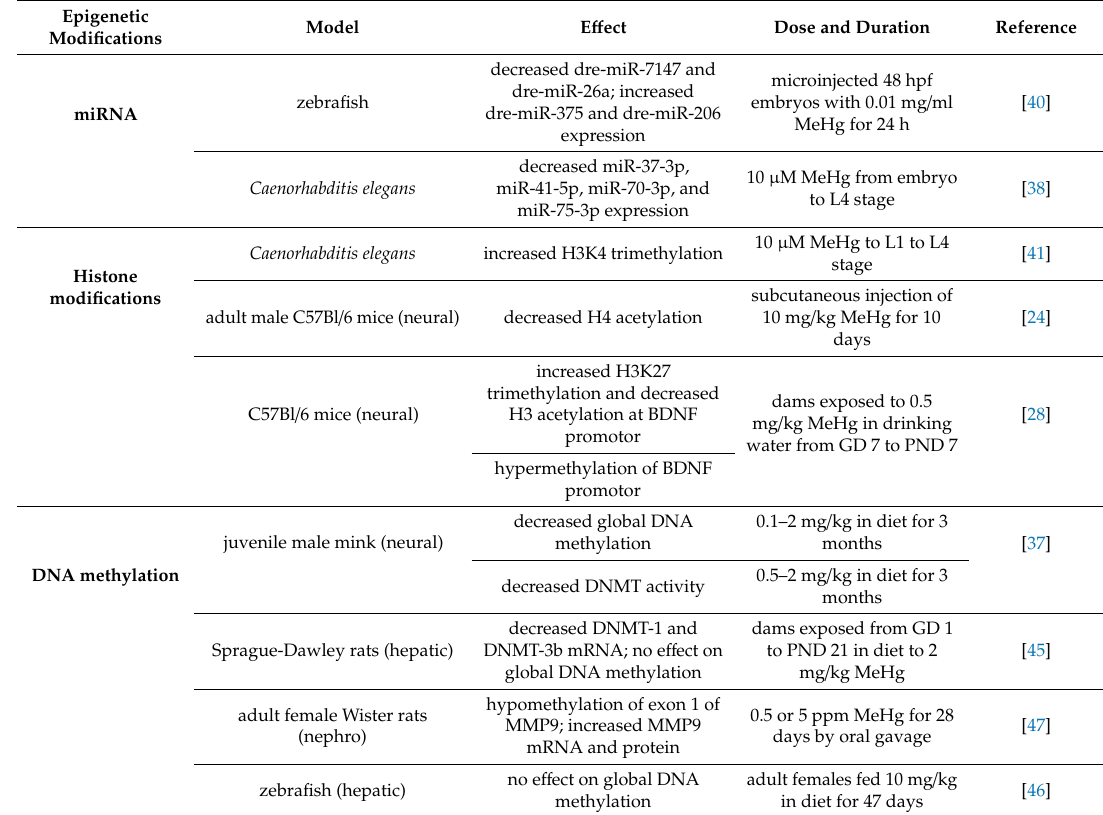
Table 2. Methylmercury-induced epigenetics modifications in